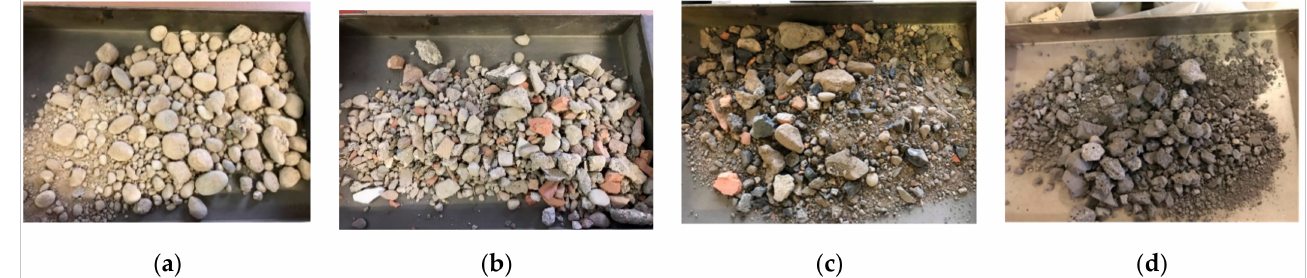
Figure 2. M040 virgin aggregate ( a ); M040 CDM aggregate ( b ); FM040 steel slag and CDM ( c ); oven slug ( d